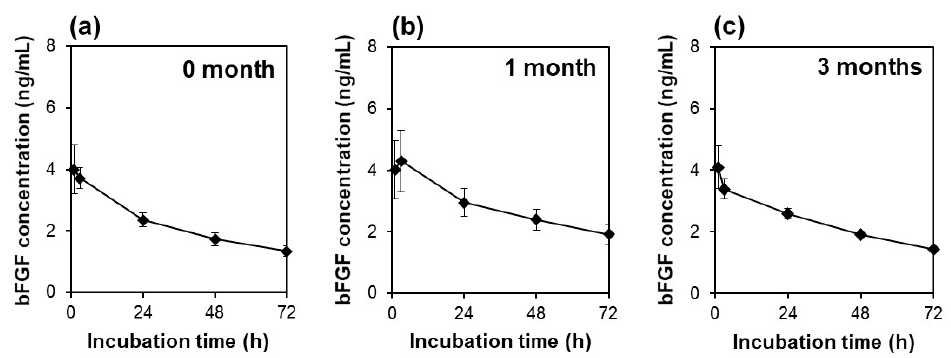
Figure 8. Variations of bFGF concentration with incubation time up to 72 h in acellular medium supplemented with the lyophilized and cryopreserved [( a ) 0, ( b ) 1, ( c ) 3 months] F4 membrane (average ± SD; n = 3).